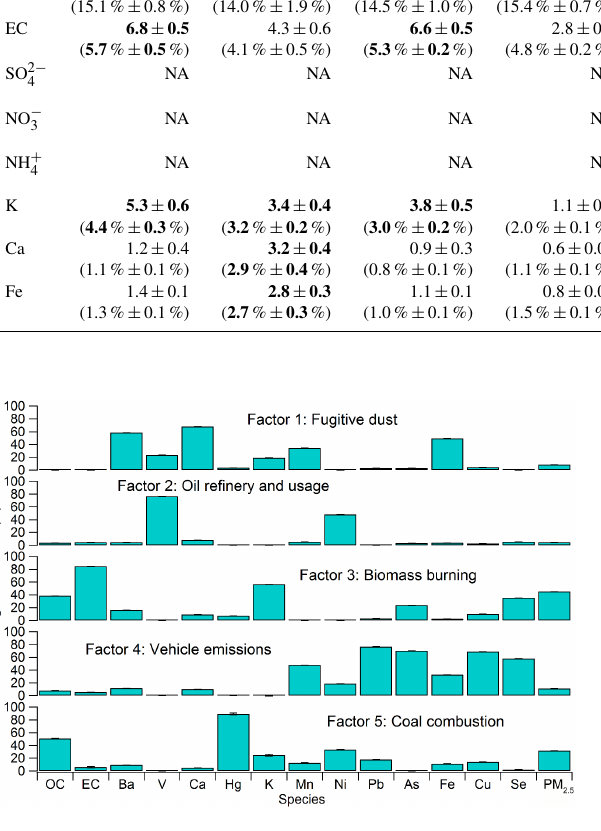
Figure 8. Profiles of PM 2 . 5 sources in summer. Error bars represent 95% CI estimated by bootstrap method in PMF. Figure 9. Profiles of PM 2 . 5 sources in autumn. Error bars represent 95% CI estimated by bootstrap method in